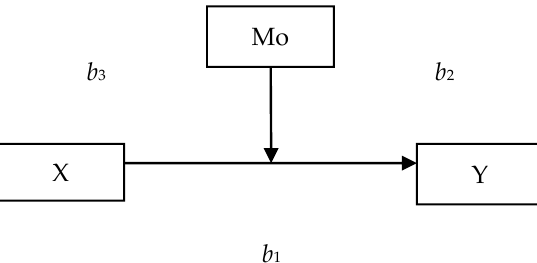
Figure 1. The moderation model; the hypothetical mediation model after Hayes [57], in which variable X (perceived stress) is a predictor, Mo (sense of self-efficacy) is a moderator, and Y (burnout) is a dependent variable. Interaction indexes: 1) b 1 refers to the influence of a predictor on a dependent variable; 2) b 2 refers to the influence of a moderator on a dependent variable; and 3) b 3 refers to interaction effect of a predictor and a moderator for a dependent variable.